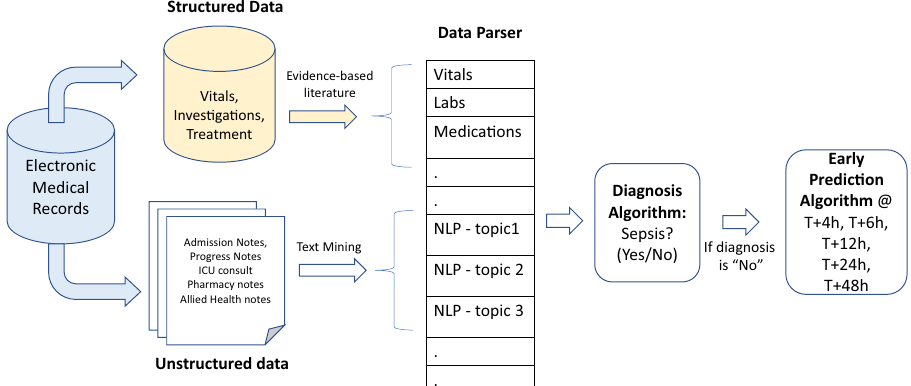
Fig. 1 Setup of SERA algorithm. The fl ow diagram shows the steps used to develop the SERA Algorithm. Both structured data (vitals, investigations, and treatment) and unstructured data (clinical notes) are used in the process of diagnosing and predicting sepsis.